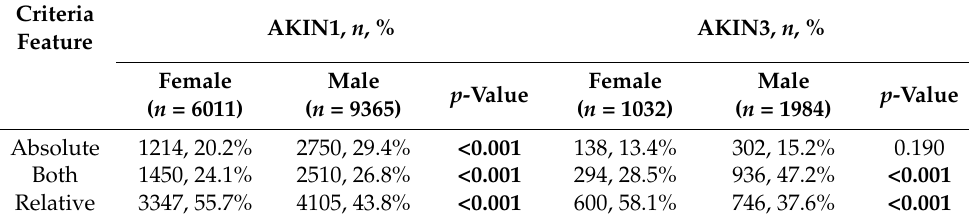
Table 5. Comparison of the proportions of progressive AKI cases within different age groups, stratified by sex. A total of 7592 AKI cases were considered for detection of progression. n —number of cases. Significant p -values (< 0.05) highlighted as